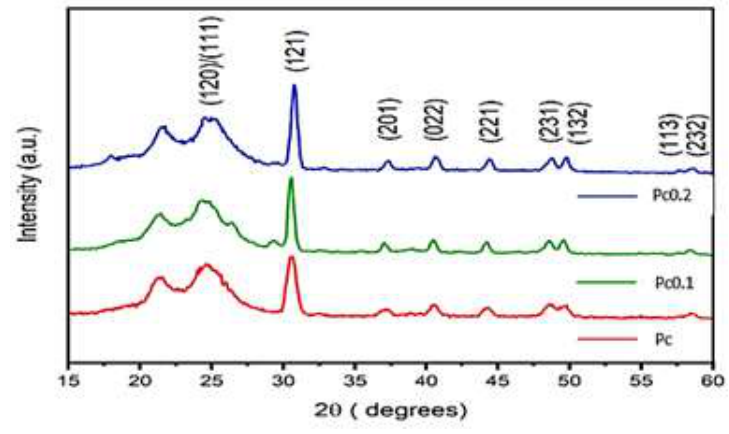
Figure 5: XRD patterns of Pc, Pco.1, and Pc 0.2.